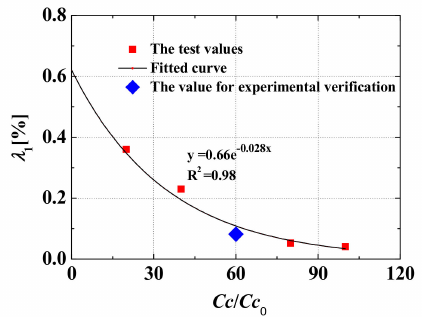
Figure 11. The relationship between parameter λ 1 and cement content Cc .